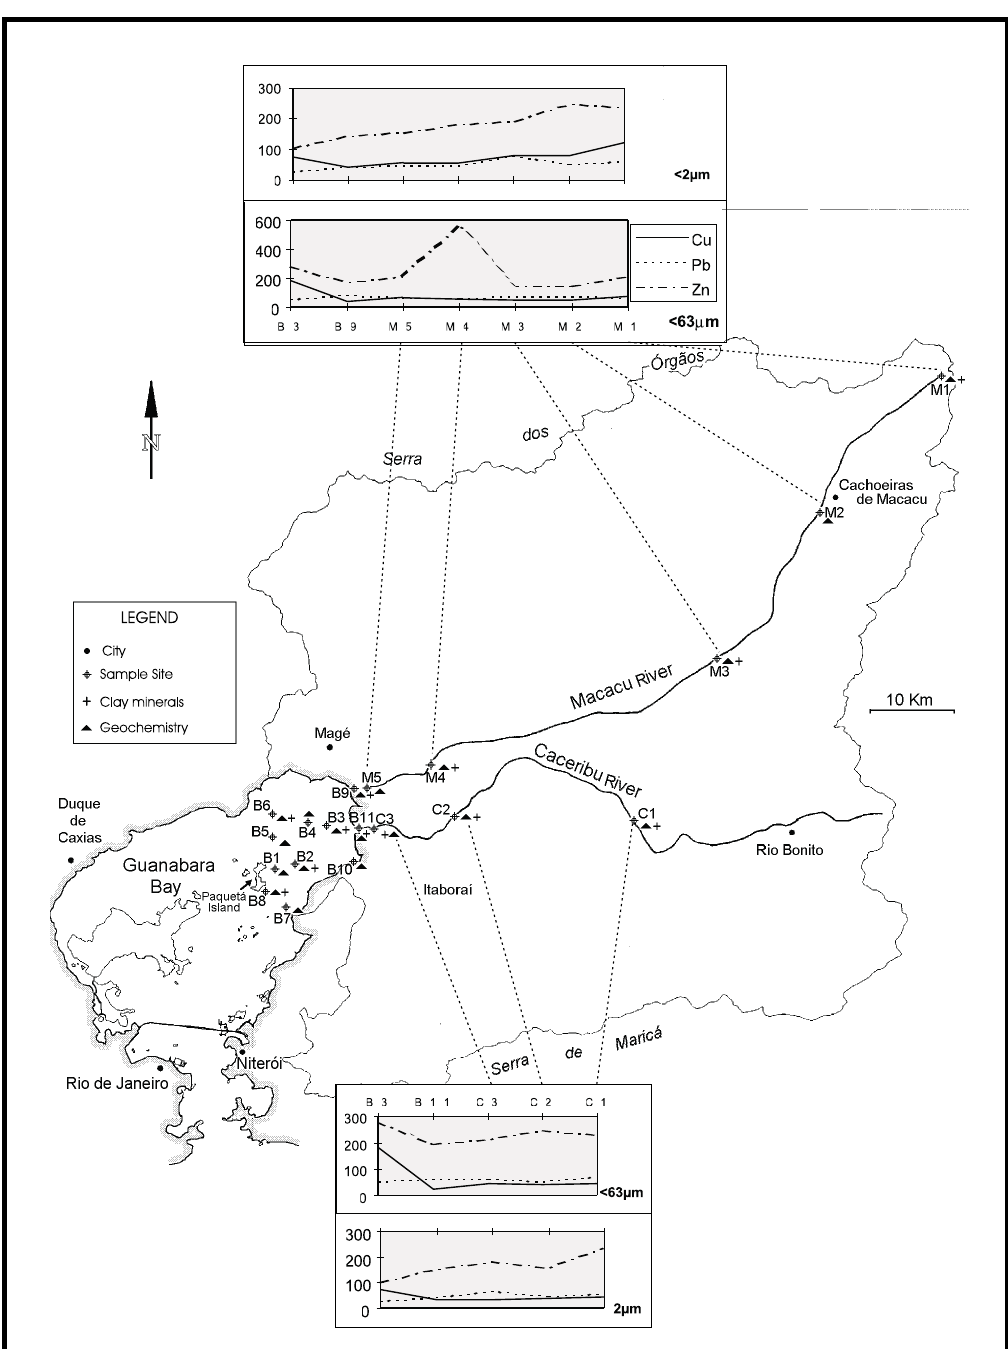
Fig. 4 – Location map of major rivers of Guanabara Bay with samples sites (M1-M5 for Macacu River, C1-C3 for Caceribu River and B1-B11 for bay stations) and heavy metals profiles (Cu, Pb and Zn in < 63 µm and 2 µm grain-size